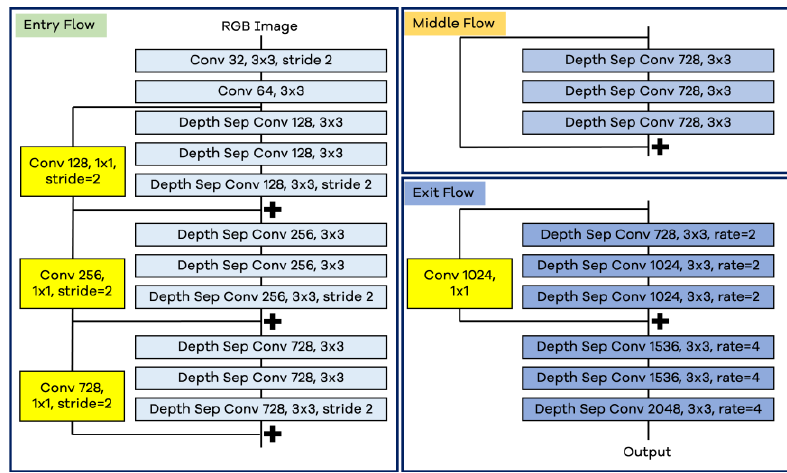
Figure 8. Modified Xception backbone.